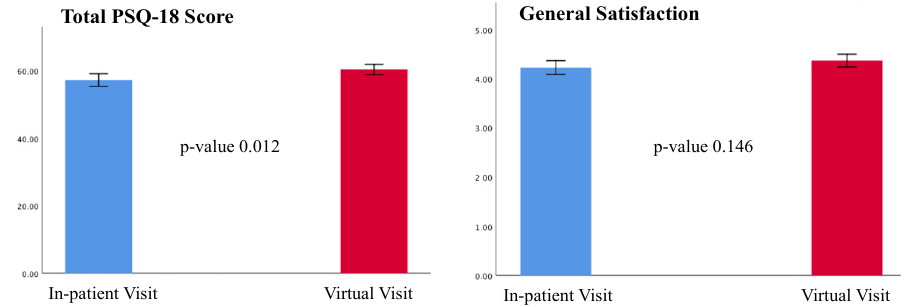
Figure 2. Results from the PSQ-18. The total PSQ-18 score and the scores for the seven subscales are shown. Results are expressed as the means and standard deviations. Blue color represents the in-patient group; red color represents the virtual visit group. The p -value for each comparison is shown. A p -value < 0.05 was considered statistically significant. PSQ-18: Patient Satisfaction Ques- tionnaire-18. 3.5. Feasibility and Safety of Virtual Visits Following the clinical evaluation, no changes in medical therapy were made in 143 (41%) patients, while medical therapy was changed by the cardiologist in 21% of cases according to patient status. Of note, no differences were found in the management of